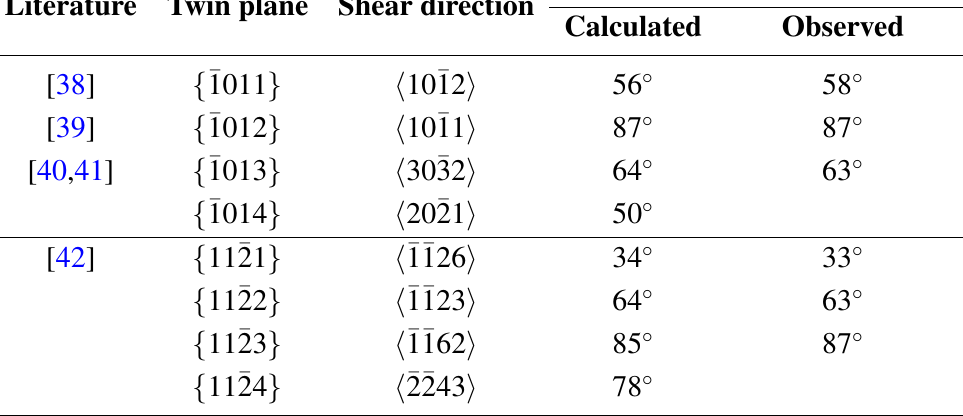
Table 1. calculated twin boundary misorientations compared to observed misorientations from Figure